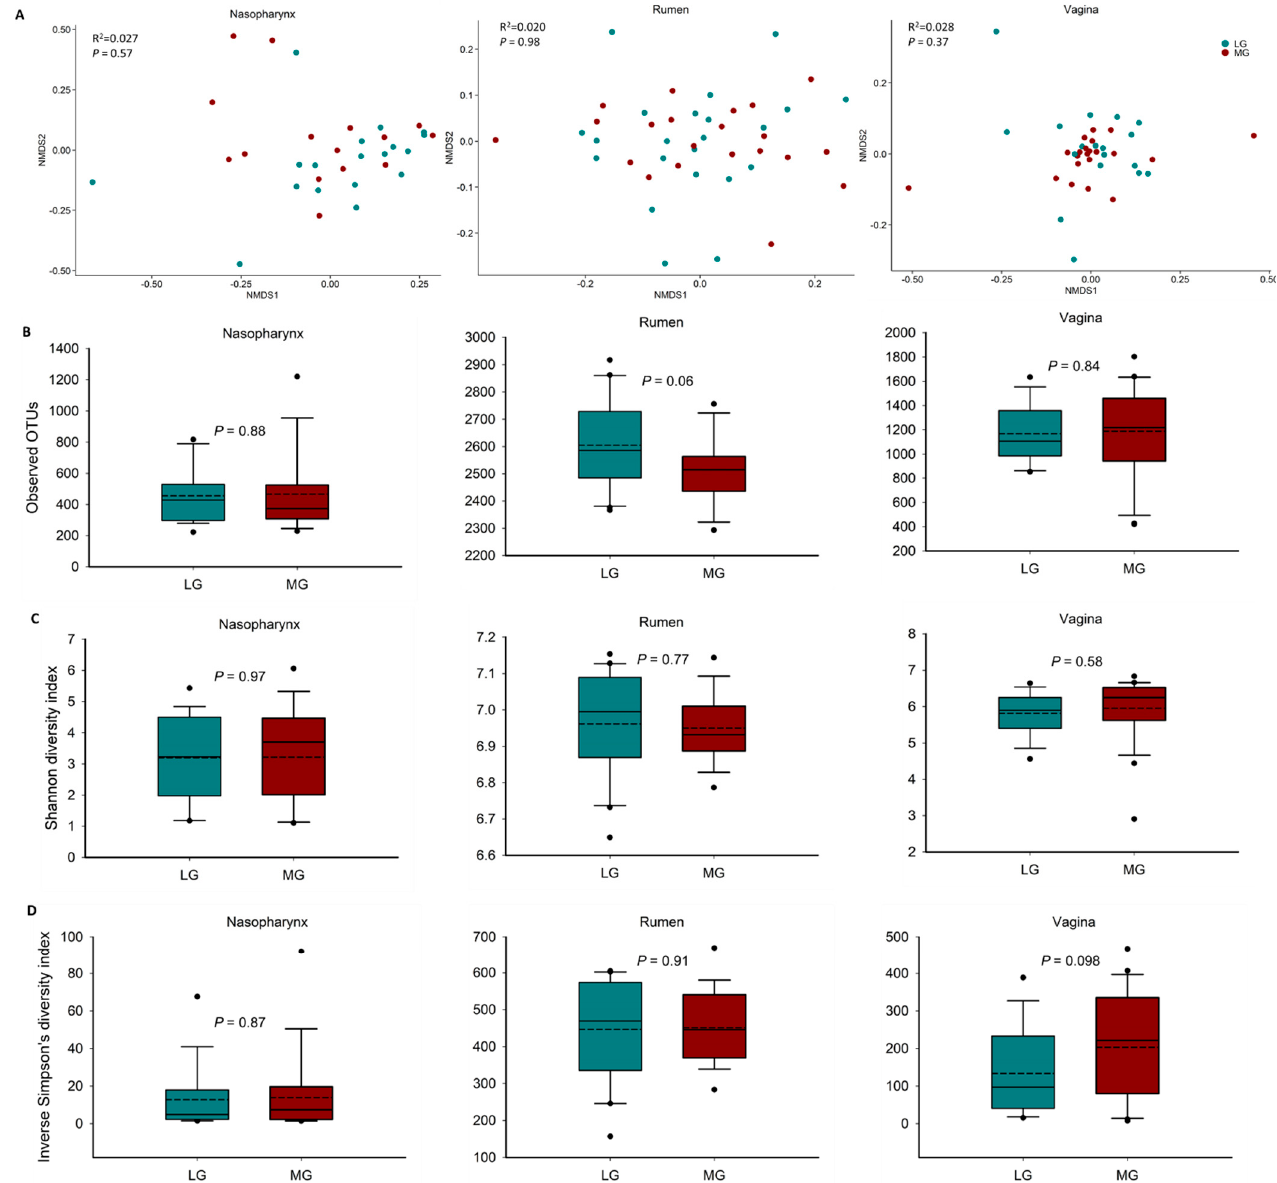
Figure 1. Beta and alpha diversity of the nasopharyngeal, ruminal and vaginal microbiota of virgin yearling heifers from low gain (LG) or moderate gain (MG) dams as determined during the first trimester of gestation. ( A ) Non-metric multidimensional scaling (NMDS) plots of the Bray–Curtis dissimilarities, ( B ) number of operational taxonomic units (OTUs), and Shannon ( C ) and inverse Simpson’s diversity index ( D ) of each microbial community.